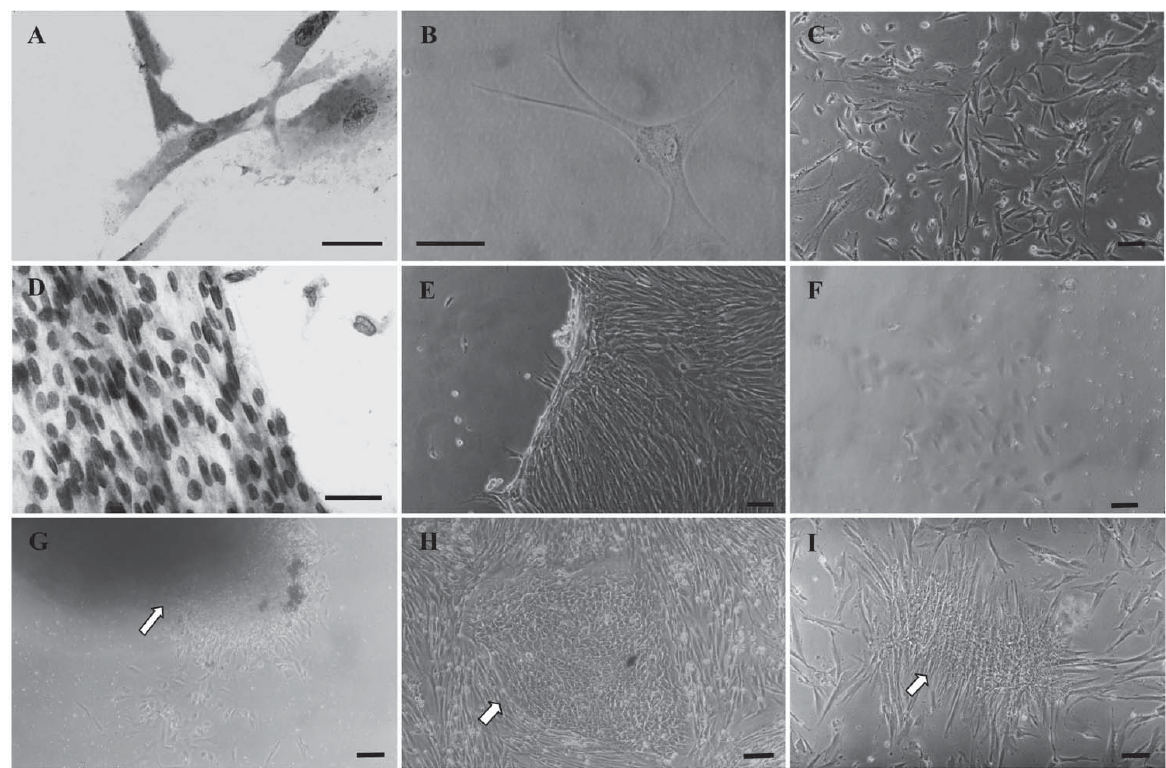
Fig. 4. Primary culture of DPCp and DPCd. (A) DPCd-C/D (100x); (B) DPCp-C/D (40x): cells exhibiting polygonal shape, with cytoplasmic extensions and predominantly fibroblast-like morphology. (C) DPCd-C/D (20x) showing spindle-shape appearance and polygonal contours with cytoplasmic extensions. (D) DPCp-C/D (40x) and (E) DPCd-C/D (20x) after 3 culture passages: cells expanded and formed condensed multilayer stripes of cell masses. (F) DPCd-C/D cells (20x) with spherical shapes and epithelial or endothelial-like cells contours. (G) DPCd-OG cells (20x) migrating from the tissue fragment (arrow). (H) and (I): confluent cultures of DPCd-C/D (20x and 40x, respectively) showing colony-forming units. (A) and (D ) stained with Giemsa. Scale bars: 50